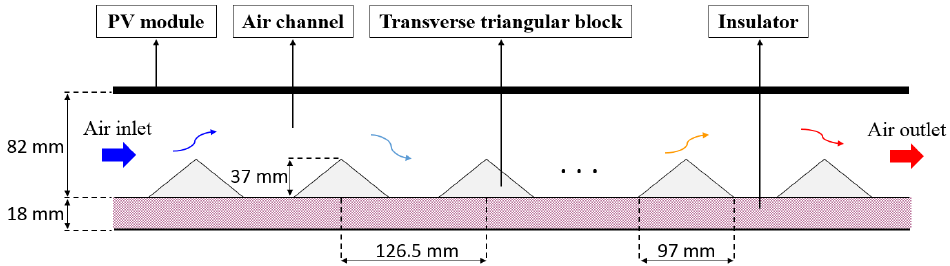
Figure 2. Side view of the PVT air collector having a triangular block with airflow in an air duct and dimensions. (Reprinted/adapted with permission from Ref. [33]. Copyright 2020, Elsevier Ltd.).